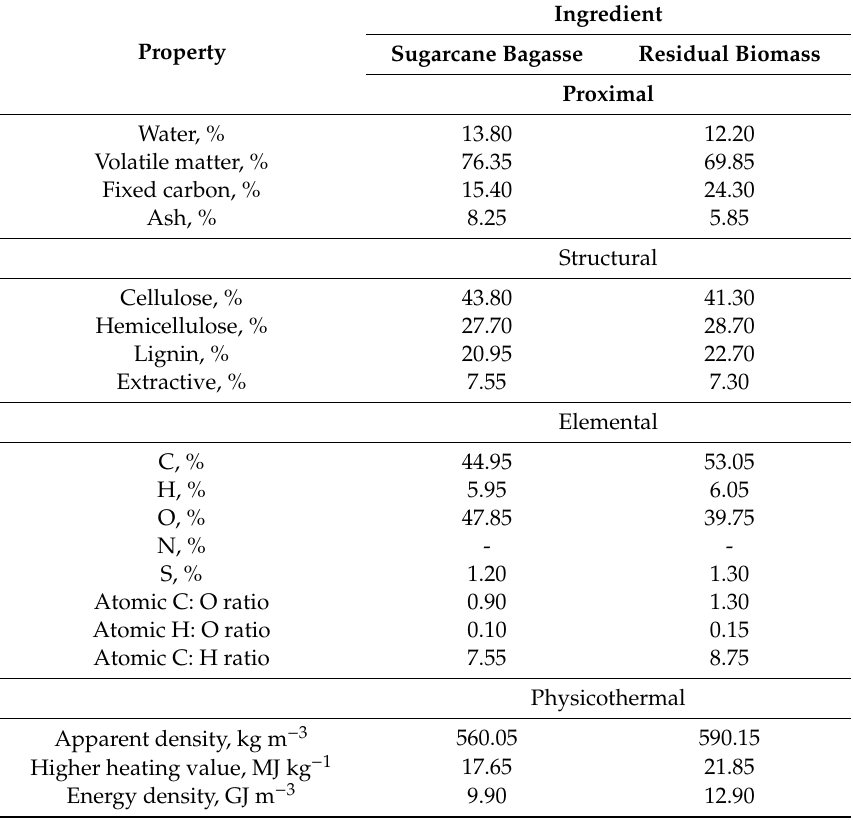
Table 1. Physicothermal properties of the ingredients for making hybrid non-wood pellets. Ingredient Property Sugarcane